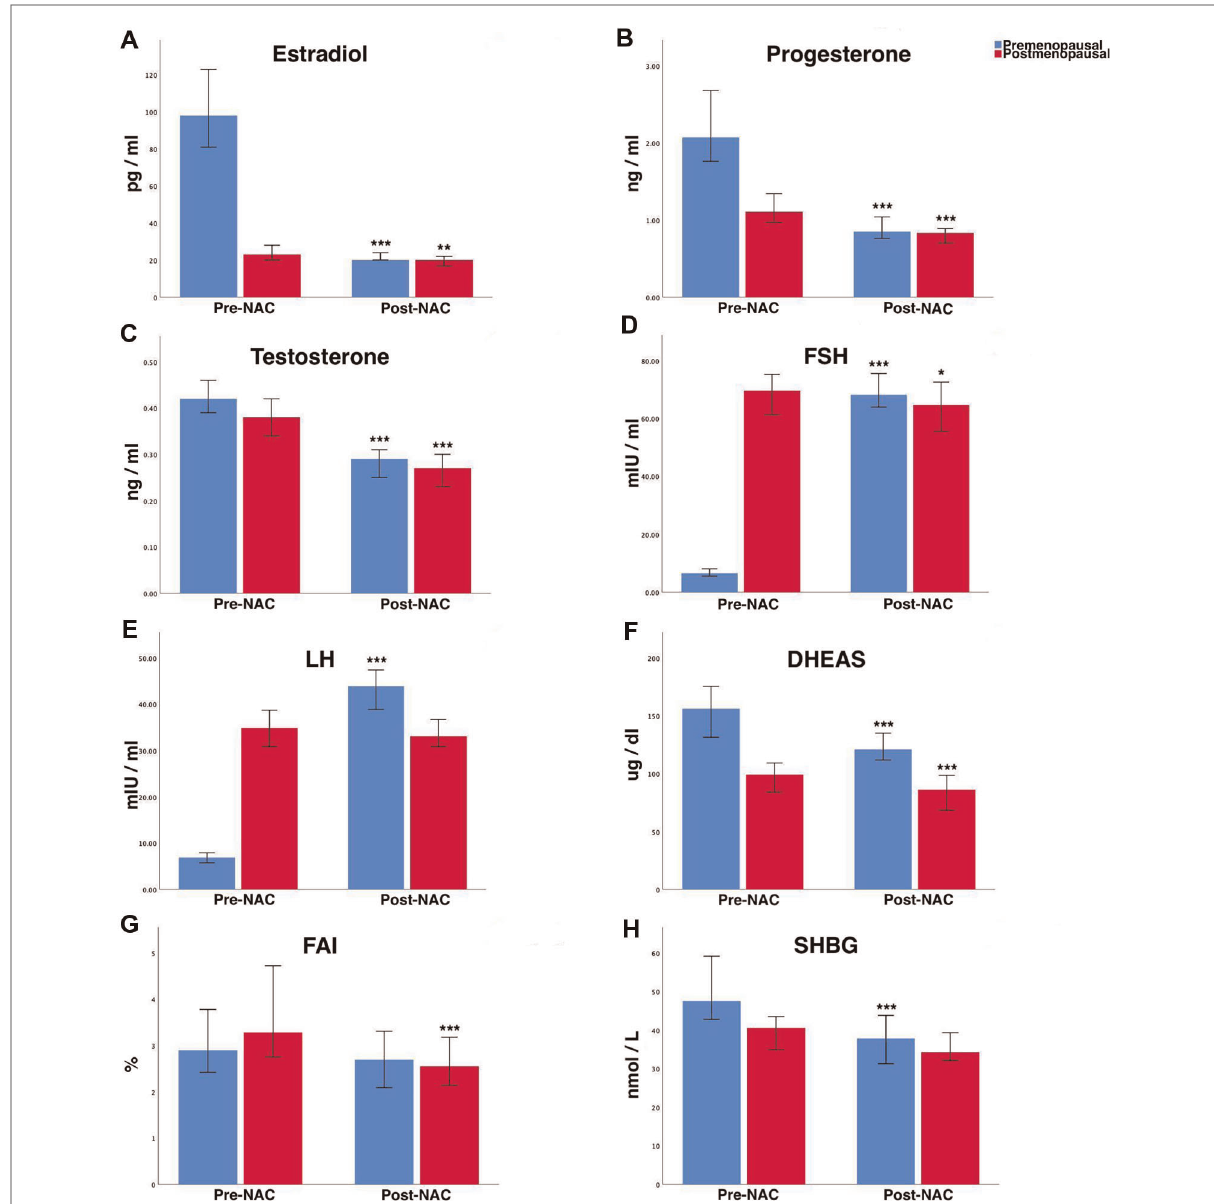
FIGURE 2 Changes of various serum reproductive hormones after NAC treatment in premenopausal and postmenopausal women with breast cancer. ( A ) Estradiol, ( B ) progesterone, ( C ) testosterone, ( D ) FSH, ( E ) LH, ( F ) DHEAS, ( G ) FAI, and ( H ) SHBG. Values are expressed as medians, and 95% CI are shown by whiskers. * P <0.05; ** P <0.01; *** P <0.001 ( P -value by Wilcoxon signed-rank test). NAC, neoadjuvant chemotherapy; FSH, follicle stimulating hormone; LH, luteinizing hormone; DHEAS, dehydroepiandrosterone sulfate; FAI, free androgen index; SHBG, sex hormone-binding globulin; 95% CI, 95% con fi dence